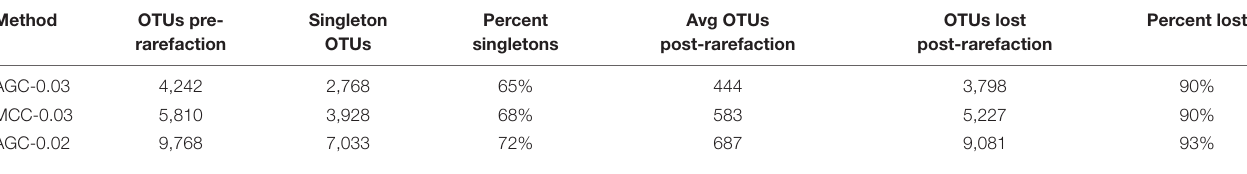
TABLE 1 | nifH OTU table and rarefaction characteristics for each clustering